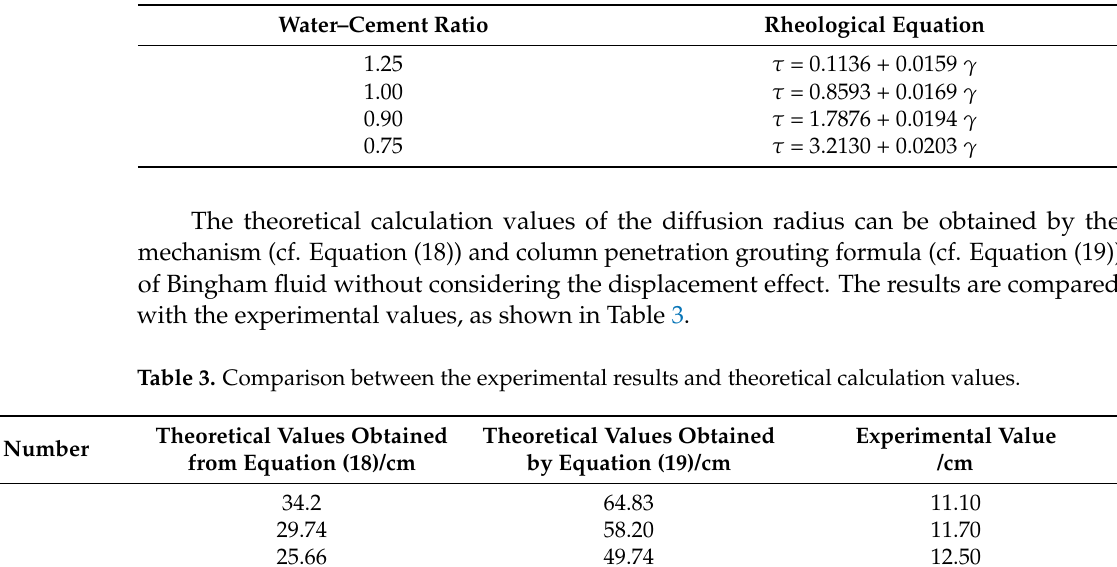
Table 2. Rheological equations of two kinds of cement grout [30].